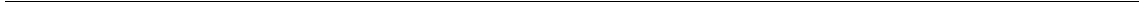
Fig. 4. Example runs of surface stimulation data. Panel (a): HS stimulation alone; Panel (b): HS+GM+Quads stimulation combined; Panel (c): GM stimulation alone. These examples demonstrate a good, an intermediate, and a poor result, respectively. In each panel the top row shows the raw data (accuracy ± 1.3kPa (10mmHg)), and the bottom row shows only cells with pressures of ≥ 8kPa (60mmHg). In each case rest data is shown in the first column, stimulation data in the second column, and the difference between rest and stimulation in the third column (Matlab™). Note particularly the differences in pressure and in contact surface area, on the stimulated sides during stimulation vs. rest. MPZs=Mean Pressure Zones (R. upper image in each panel): User-defined areas in each quadrant in which we compare the average pressure at rest and during stimulation. They are the same size and shape in all 4 quadrants (see text). These examples demonstrate a 19% decrease in average pressure beneath the ipsilateral buttock during stimulation of HS (Panel (a)), but a 5% increase when HS stimulation is combined with GM and quadriceps (Panel (b)), and a 24% increase with GM stimulation alone (Panel (c)). Weight shifts to the thighs indicate successful unloading. PPA=Peak Pressure Area (lower images in each panel): Area of cells with pressures of ≥ 8kPa (60mmHg) beneath the ipsilateral buttock. These are areas in which we believe capillaries within the deep tissues are likely to remain occluded and at risk of DTI (see text). The PPA’s size (area) and position (% overlap and centroid shift) are compared at rest and during